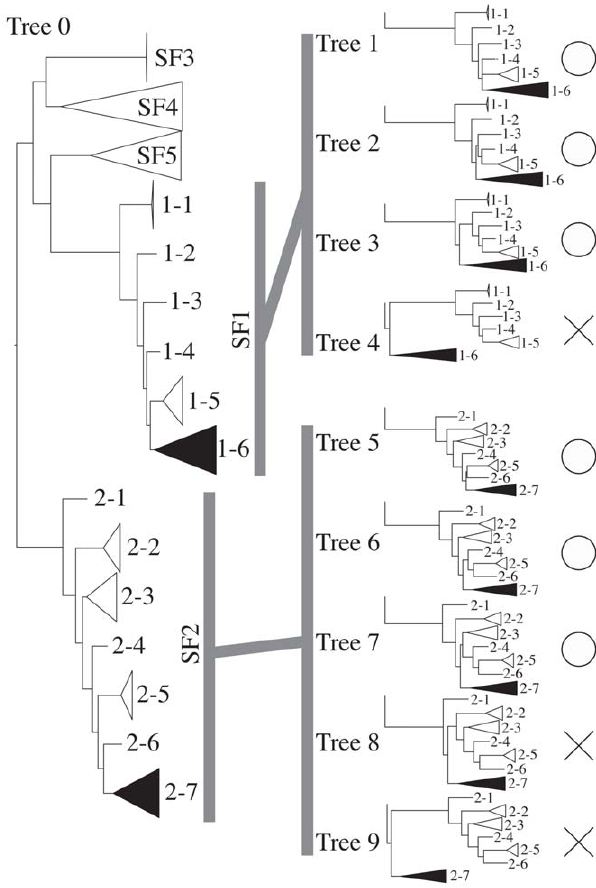
Figure 3. Tree topologies for the SH test of GHF5. Tree 0 is the original topology that was inferred by RAxML. From 1–1 to 2–7 were indicated the sub-sub-families that were showed in Fig. 2 (SSF1–1 - SSF2–7). SSF1–6 and 2–7 were composed with the symbiont sequences of sub-family 1 and 2, respectively. Cross marks and open circles indicate that the topology can be rejected or not, respectively.